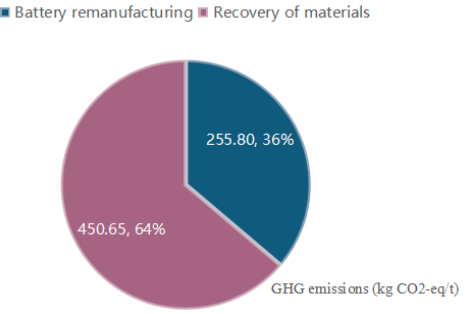
Figure 6. Contribution of different processes to total GHG savings.